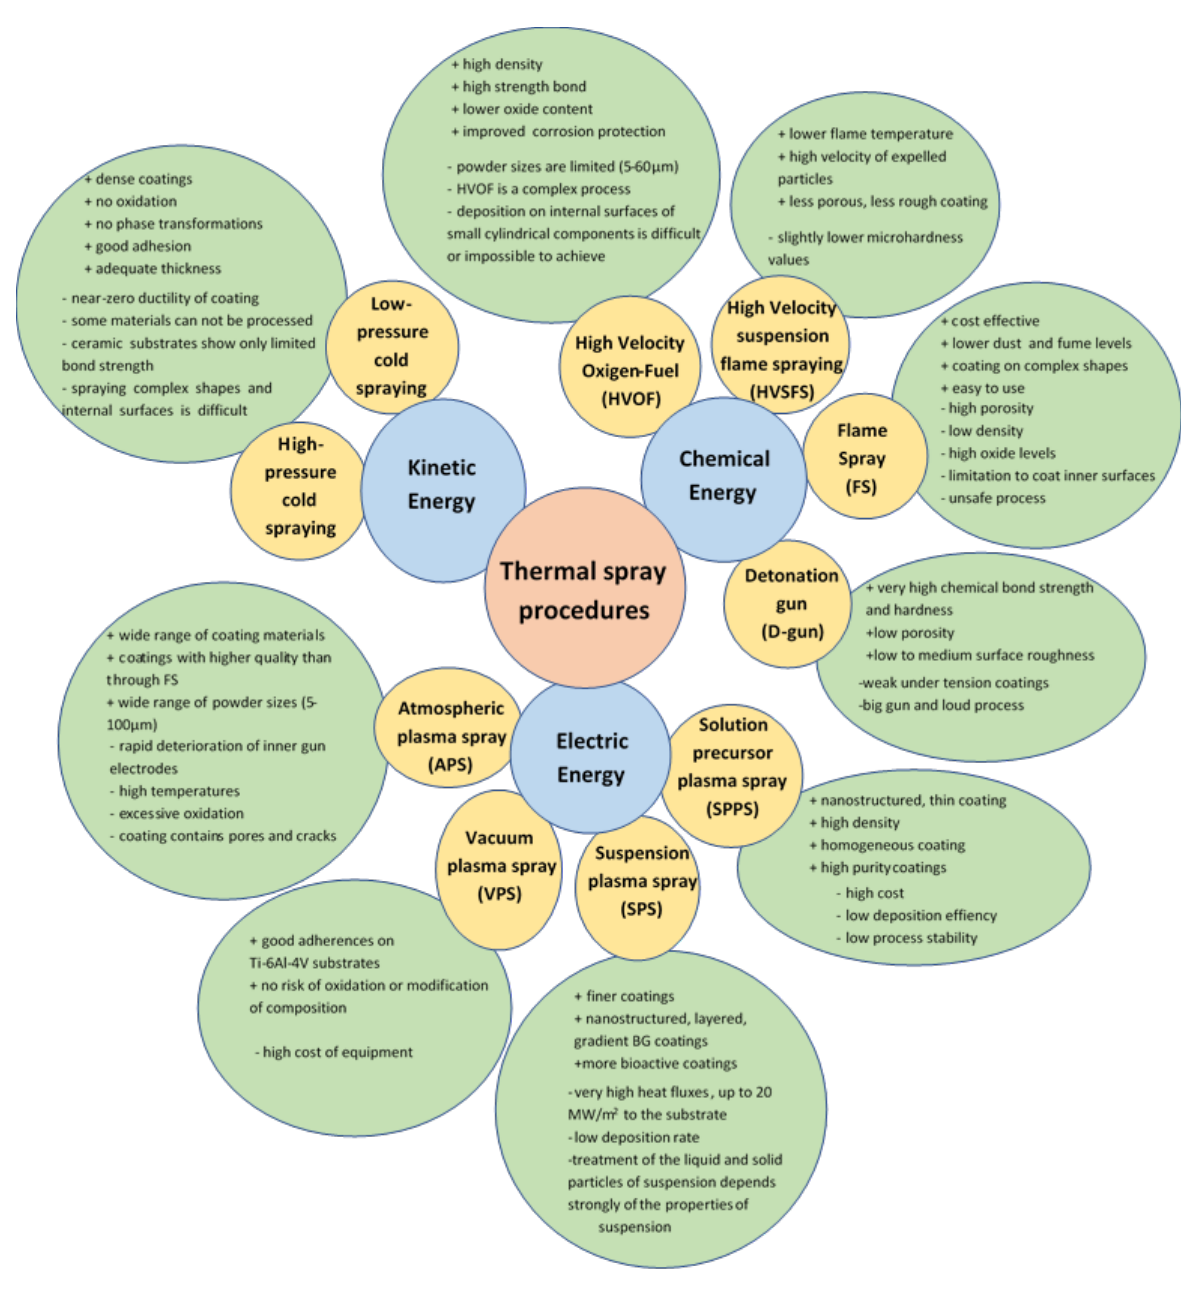
Figure 1. Thermal spray deposition technique and its characteristics [91 – 96].